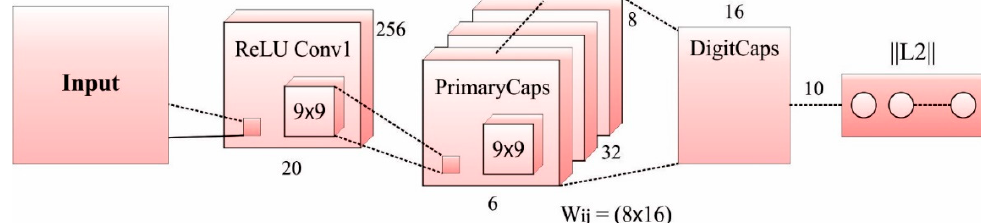
Figure 3. CapsNet Architecture.